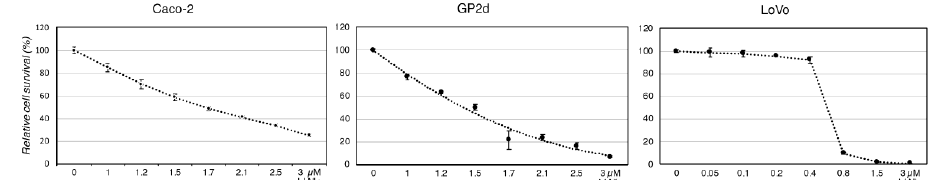
Figure 1. LLNle causes a concentration-dependent inhibition of survival in Caco-2, GP2d and LoVo cell lines. An MTT assay was performed after 72 h of treatment of the indicated cell culture, n = 4 replicas were performed and average values and SD are shown for each concentration indicated on the x -axis. An interpolation curve of survival values is shown for the GP2d cell line.